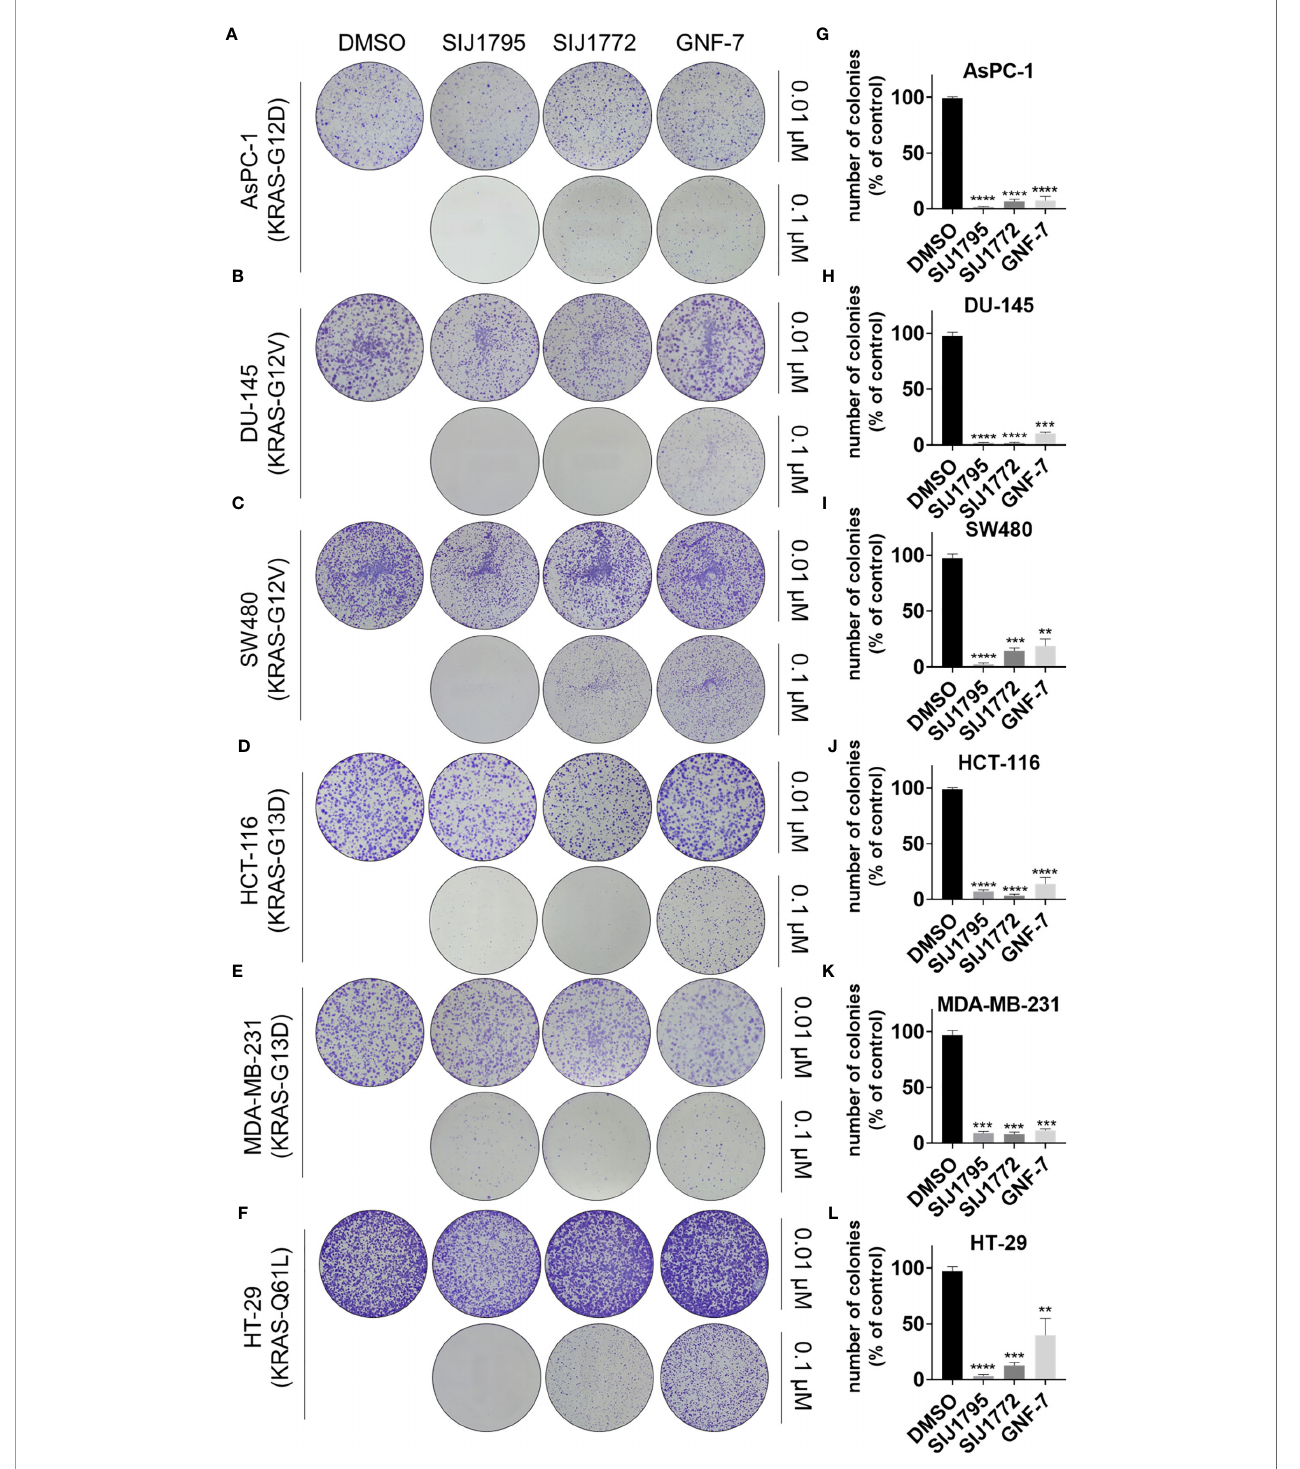
FIGURE 7 | (A – F) Colony formation assay results evaluating the effects of SIJ1795 and SIJ1772 on clonogenic abilities of on cancer cells harboring mtRAS. Cells were incubated with indicated compounds (0.01 µM or 0.1 µM) for 14 days. After staining with crystal violet, colonies were photographed without magni fi cation. (G – L) Number of colonies (% of control) upon treatment with indicated compounds at 0.1 µM concentration were determined by ImageJ (n = 3, respectively). Statistical signi fi cance was calculated by using a one-way ANOVA analysis (**p < 0.01, ***p < 0.001, ****p <